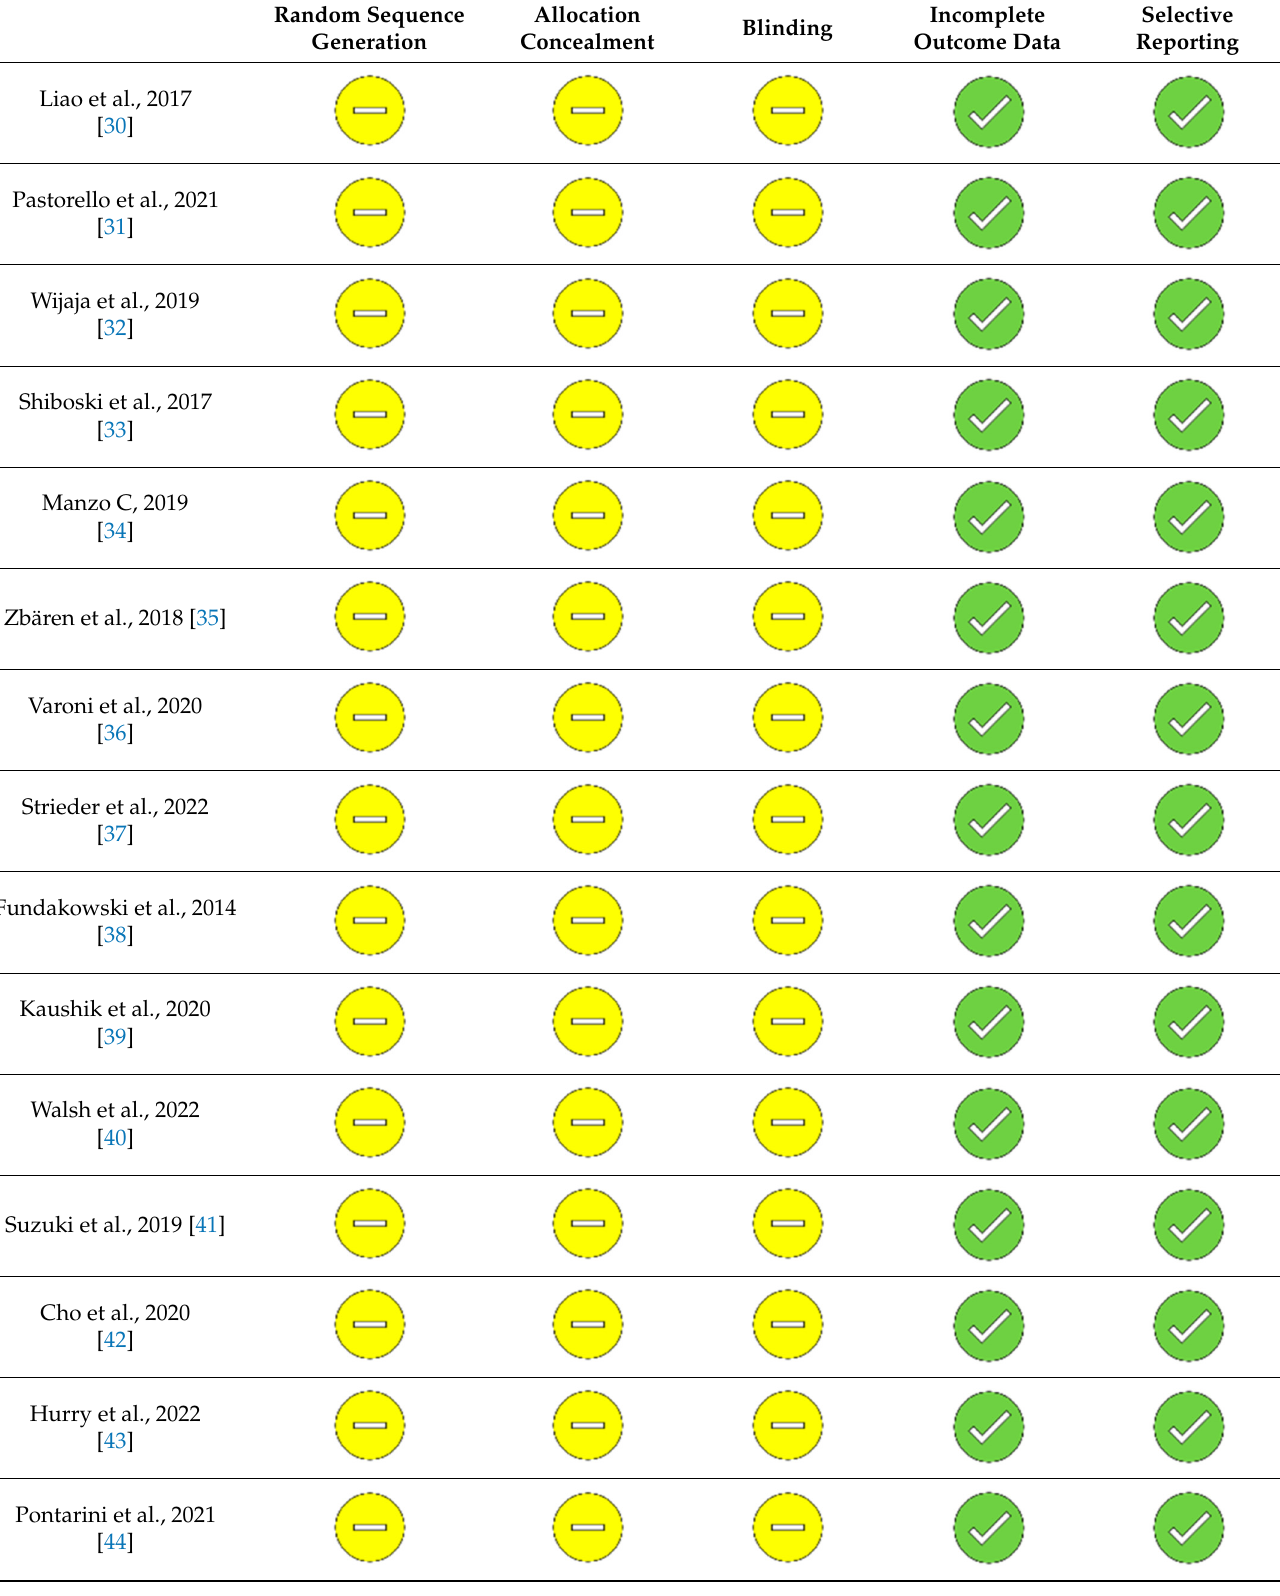
Table 1. Risk of bias of studies is represented by the green symbol, low risk of bias, and the yellow symbol, high risk of bias.